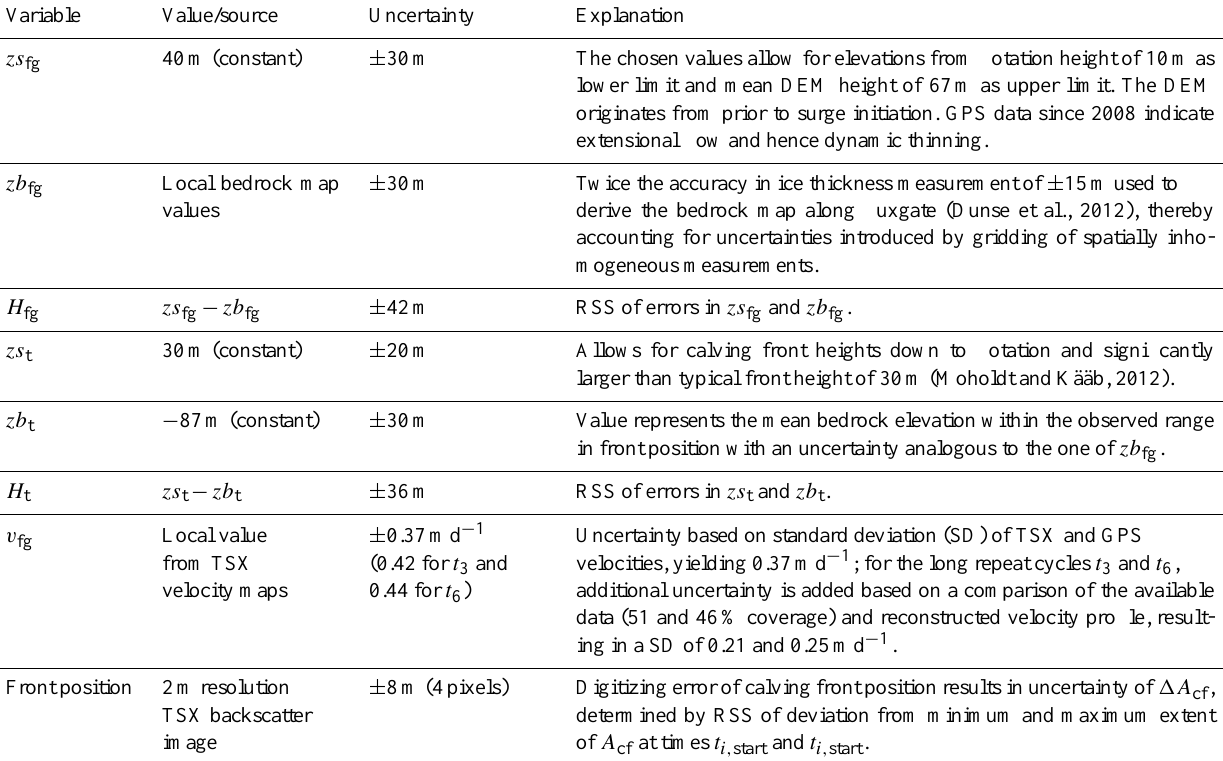
Table B1. Calving flux input variables – values, sources and